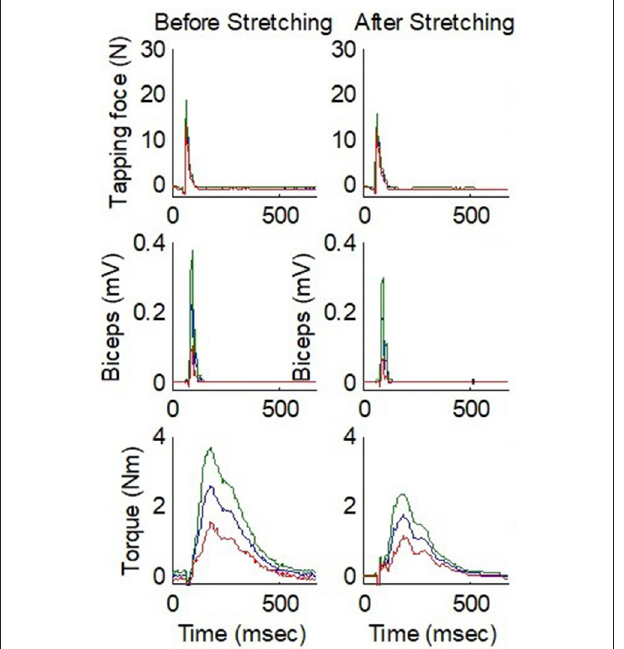
FIGURE 5 | Elbow flexion and extension passive range of motion (PROM) before and after a single stretching session. Error bars represent standard deviation. *Stands for statistically significant difference p < 0.05 from Wilcoxon Signed Rank